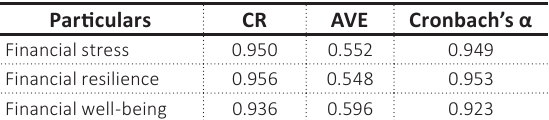
Table 6. Statistical properties of the constructs Source: Analysis of survey data.